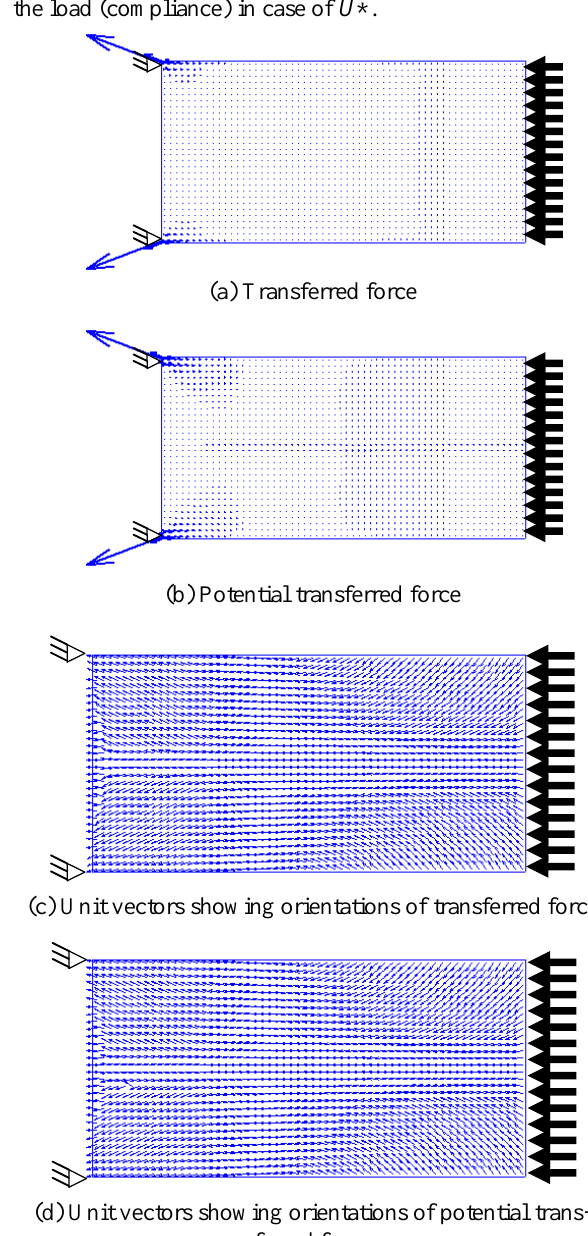
Fig. 19. Transferred and potential transferred force to the reaction points with distributed loading in the x